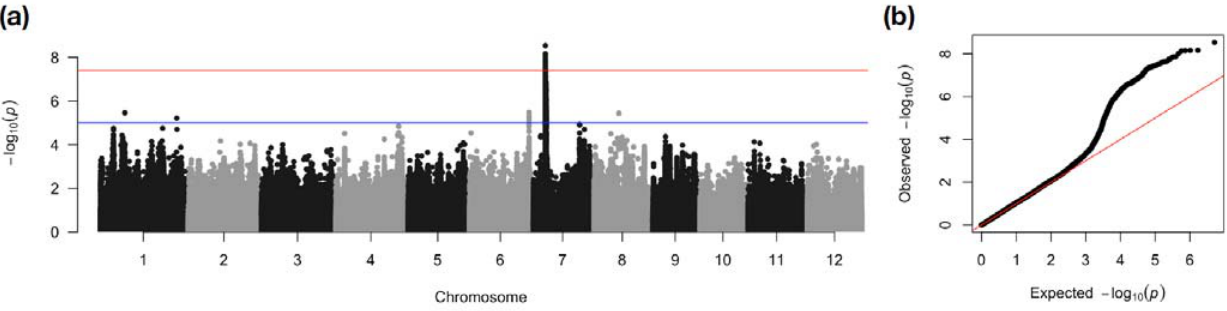
Figure 2. Detection of AG2 peak on chromosome 7 in the enriched GWAS panel. ( a ) The Manhattan plot shows the level of significance for SNPs correlated with AG tolerance from the GWAS analysis (numbers across the x-axis indicate the chromosome). ( b ) The QQ plot is shown at the right. The blue line indicates the p < 0.00001 threshold and the red line indicates the Bonferroni correction.